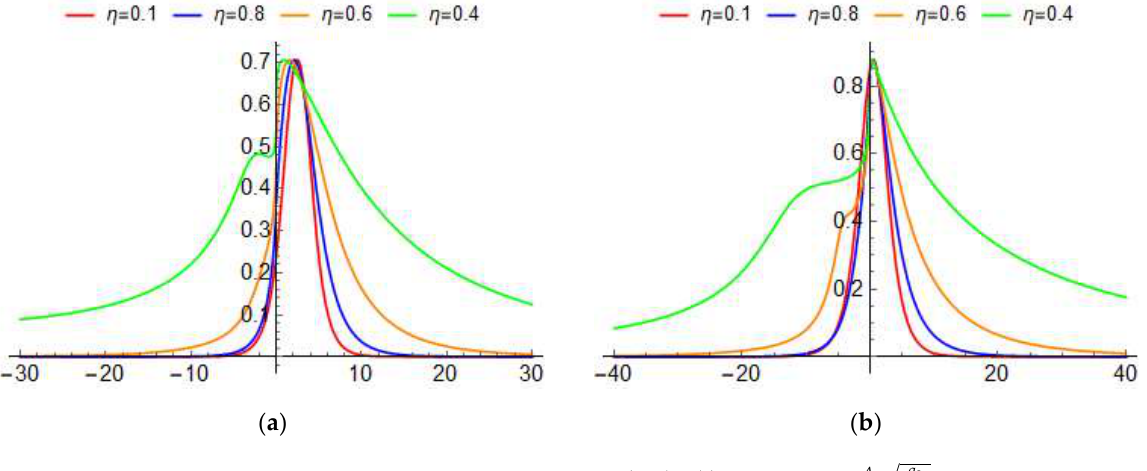
( b ) Figure 7. Variation of the inferred bright soliton solution (26), |𝜓 (cid:2870) (𝑥, 𝑡)| , where 𝑚 = − (cid:3002) (cid:3081) (cid:3495) (cid:3044) (cid:3118) (cid:2870)(cid:3044) (cid:3119) for (1): ( a ) with the group velocity dispersion parameter 𝑎 1 where: 𝐴 = ℬ = 𝑎 (cid:2869) = 1,𝑞 (cid:2870) = 1.8,𝑞 (cid:2871) = 1.3,𝛾 = 0.5,𝑎 (cid:2872) = 0 and 𝑡 = 5 ; ( b ) detuning effect parameter 𝑎 4 where: 𝐴 = 1,ℬ = 0.3, 𝑎 (cid:2869) = 1,𝑞 (cid:2870) = 0.8,𝑞 (cid:2871) = 1.3,𝛾 = 0.5, 𝑎 (cid:2872) = 0 and 𝑡 = 1 . 5.2. Kink Soliton To construct a kink soliton solution for the governing model (1), the solution for the integer-order ordinary differential Equation (14) assumes the form: Ψ(𝜒) = 𝒜(cid:3493)1 + tanh(𝑚𝜒).